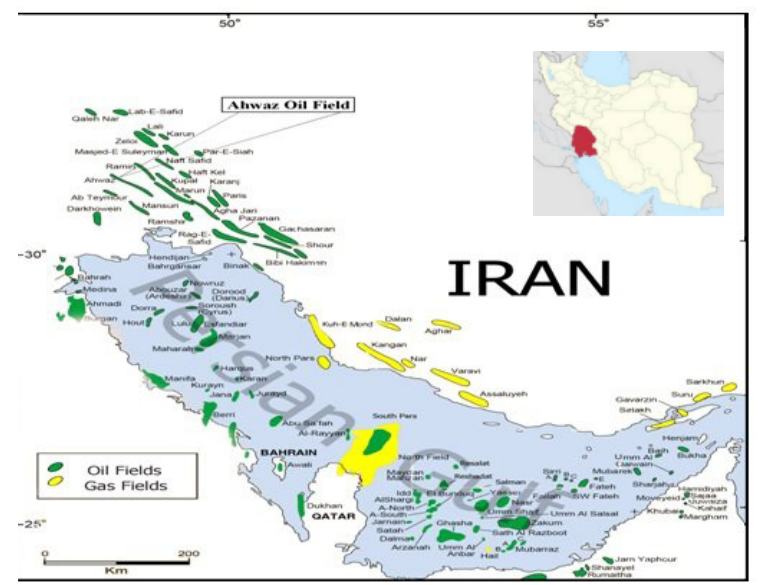
Figure 1. Ahvaz oil field in the southwest of Iran